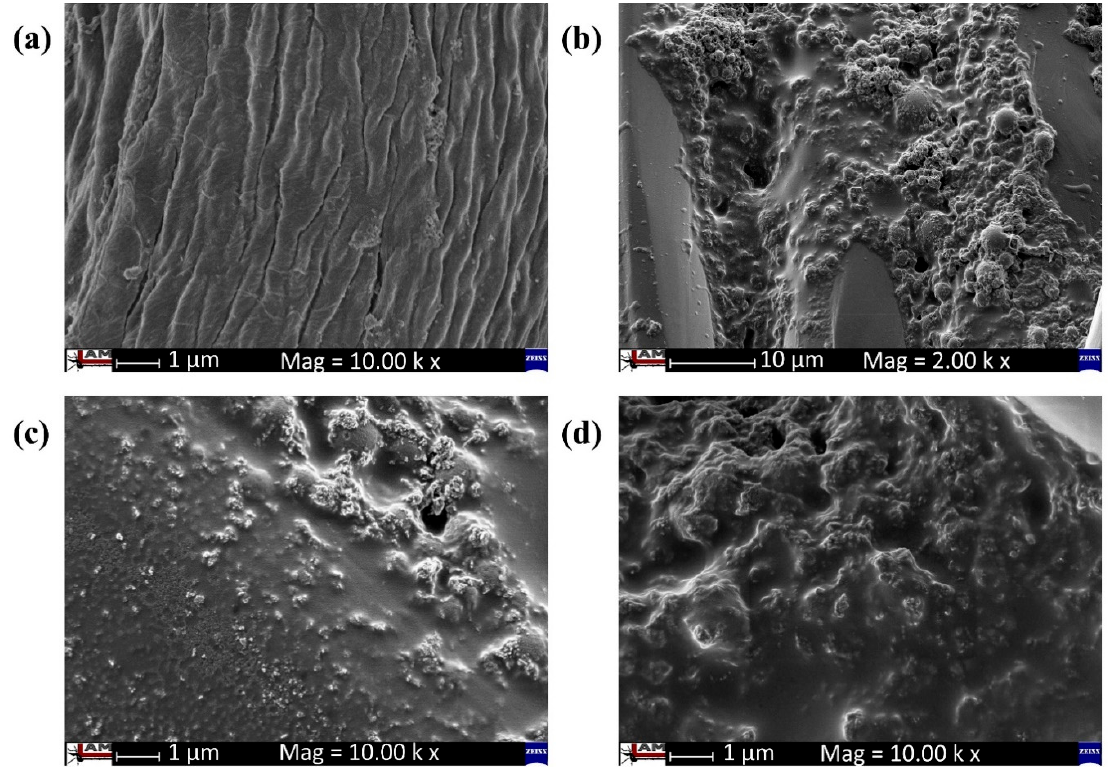
Figure 2. UHR-SEM analysis of ( a ) untreated sample, ( b ) sample C-nZnO 3, ( c ) sample C-nZnO 5, and ( d ) sample C-nZnO 7.